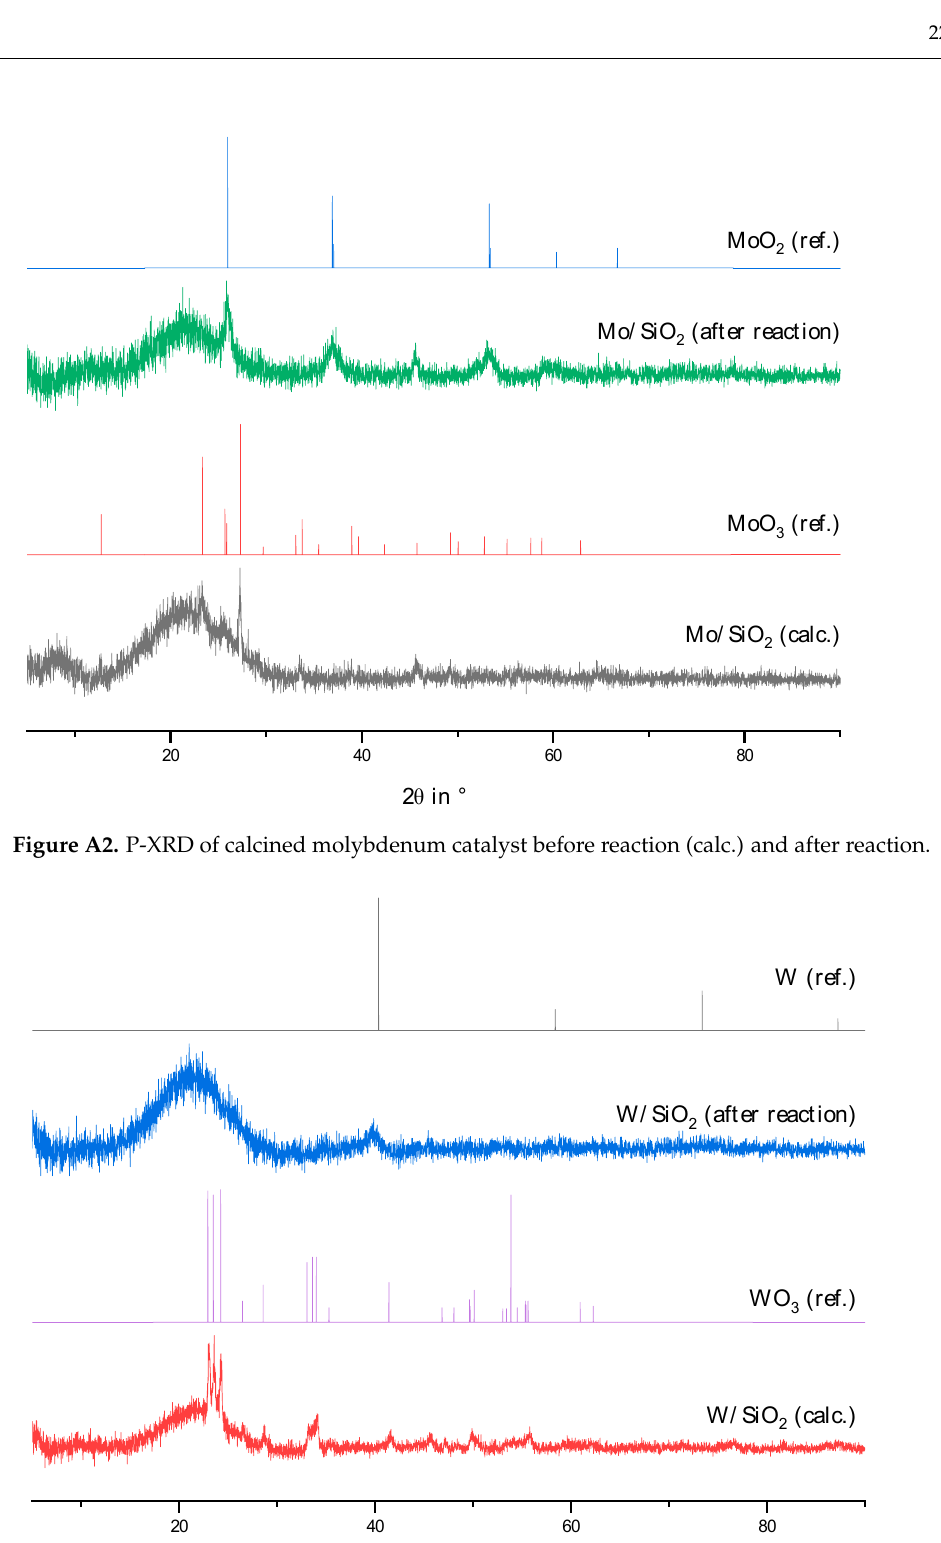
Figure A1. Results of TPROR measurements of the silica carrier material Aerosil380, 40 °C to 600 °C; total hydrogen consumption of 0.08 mmol(H 2 )/g.